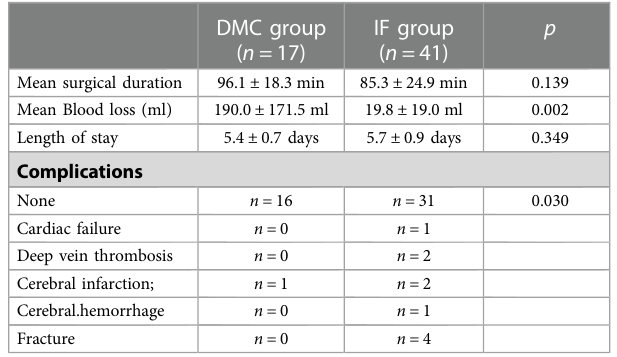
TABLE 2 Surgical data and complications. Values are shown as Mean±SD.